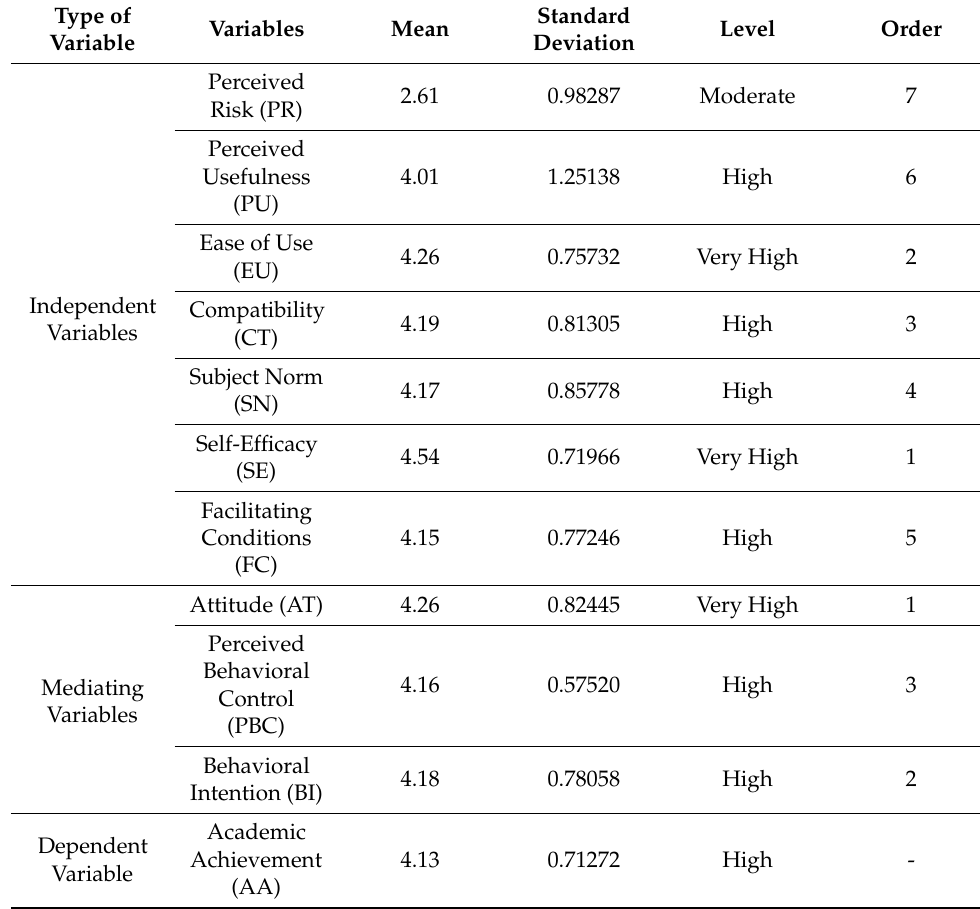
Table 3. Overall mean and standard deviation of the study’s